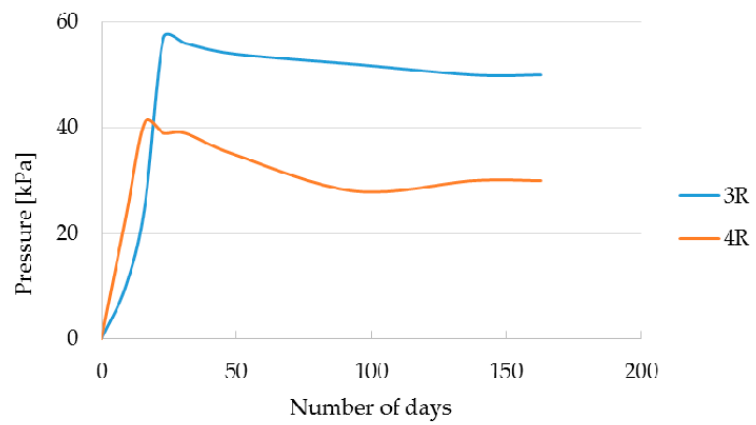
Figure 7. Measurement results of the pressure exerted on the geosynthetic based on the measurements presented in [13].